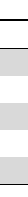
Multiple regression analysis Model